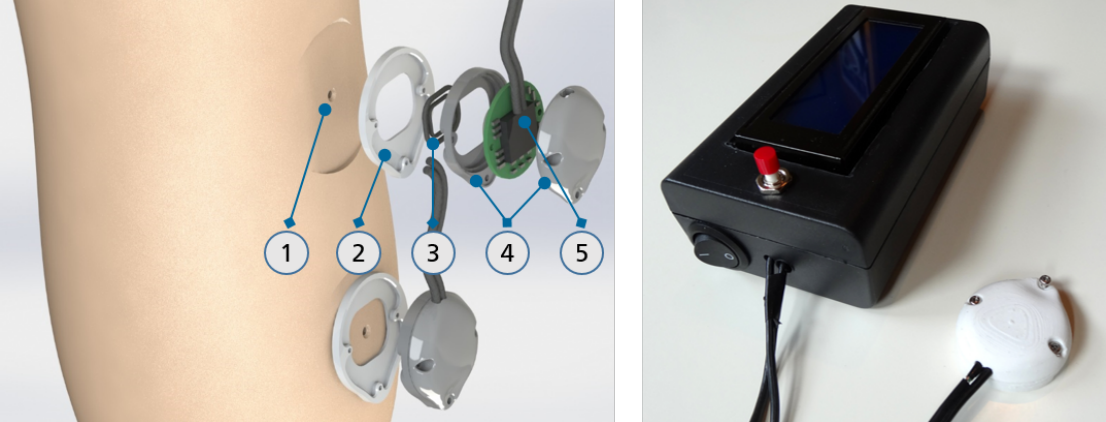
Figure 1. Exploded view of the sensor unit based on the 2D-motion sensor: 1 socket with clearance cavity, 2 mounting base, 3 seals, 4 sensor housing, and 5 sensor ( left ) as well as sensor system as a standalone, untethered, and integrated optical 2D-motion measuring system ( right